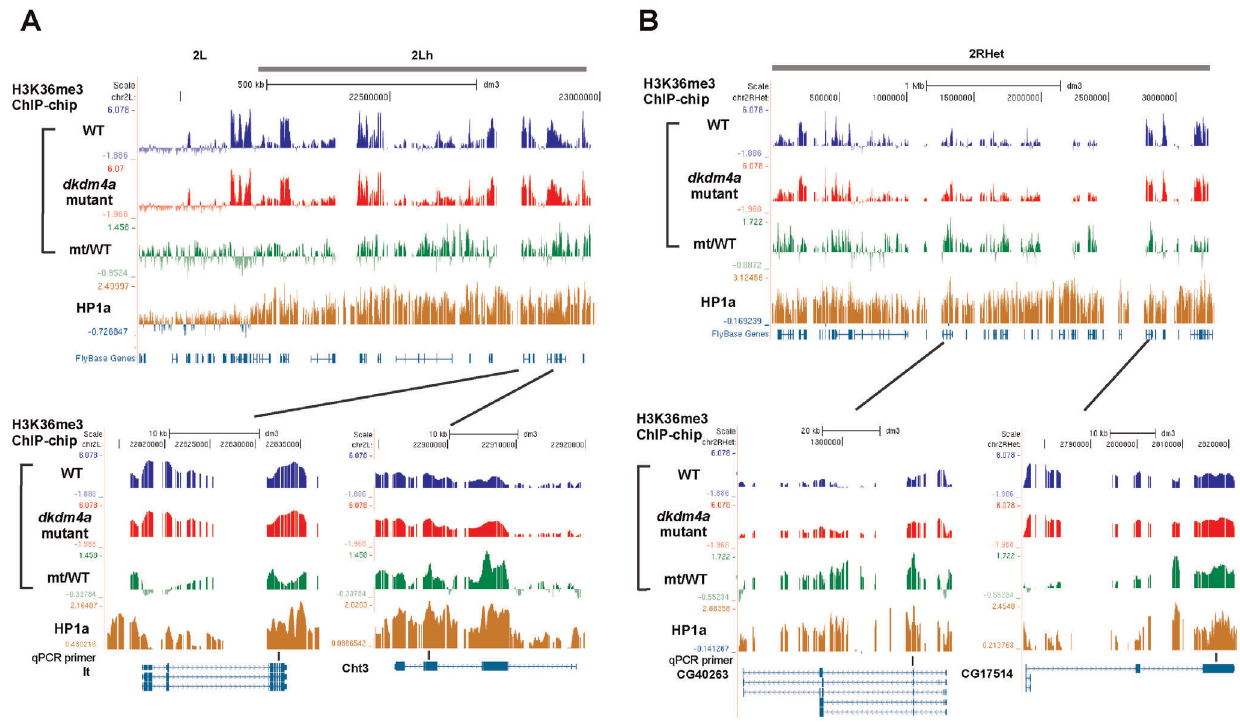
Figure 3. Profiles of H3K36me3 and HP1a ChIP-chip at heterochromatin. H3K36me3 and HP1a profiles of chromosome 2 Lh (A) and 2 RHet (B) genes. Profiles of H3K36me3 ChIP-chip are shown as in Figure 1B. The profile of HP1a ChIP-chip is shown in brown. Primers used in Figure 4B are indicated in the panel of qPCR primers.